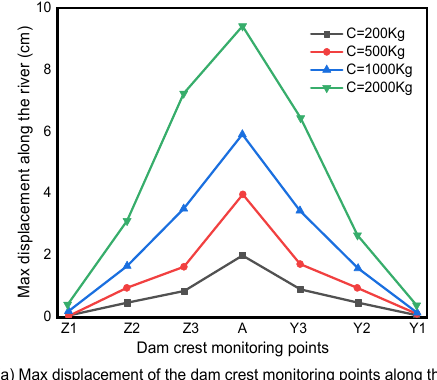
(a) Max displacement of the dam crest monitoring points along the river (b) Max displacement of arch crown beam monitoring points along the Figure 12. Cont